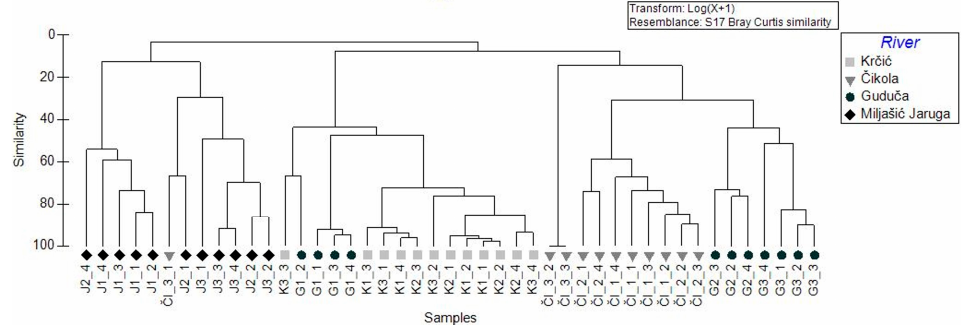
Figure 5. Cluster analysis showing similarity of mayfly assemblages among the four intermittent rivers in the karst Mediterranean region of the Balkans, Croatia. The analysis is based on Bray– Curtis similarity coefficient and species’ log (x + 1)-transformed abundances. Study sites without mayfly records were not included in the analysis.